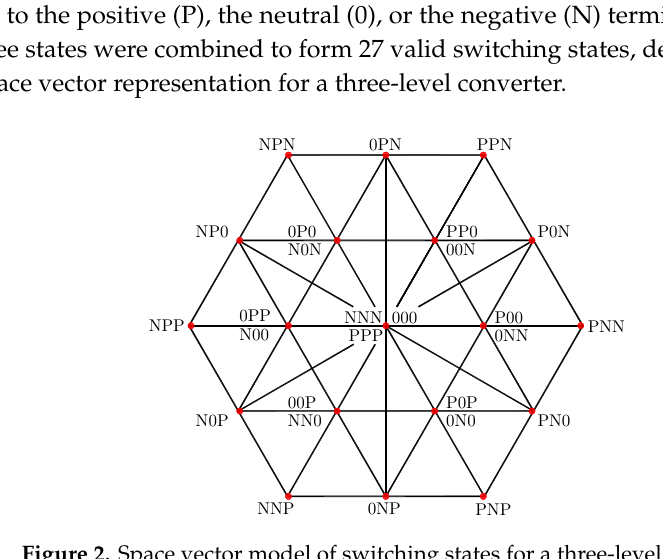
Figure 2. Space vector model of switching states for a three-level inverter.